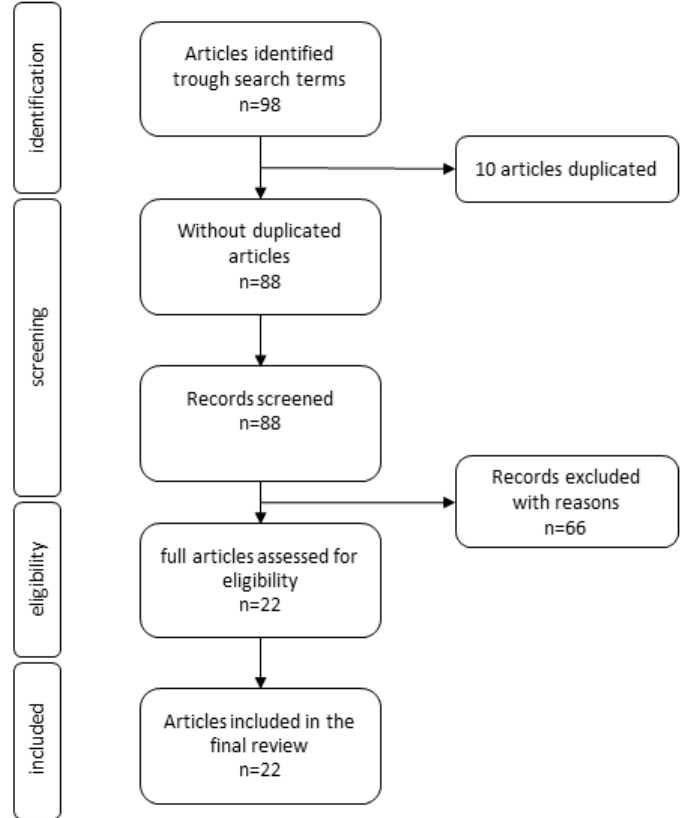
Figure 3. PRISMA flow diagram showing the study selection and identification.